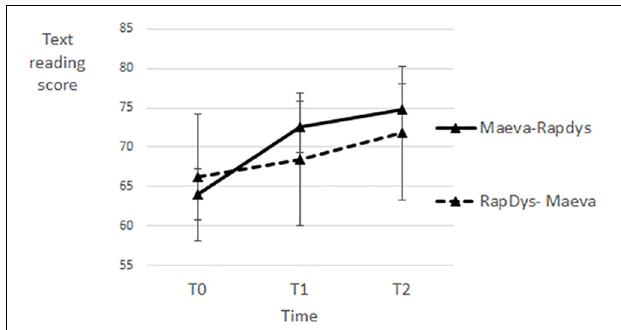
FIGURE 9 | Text reading scores for each time period and each presentation